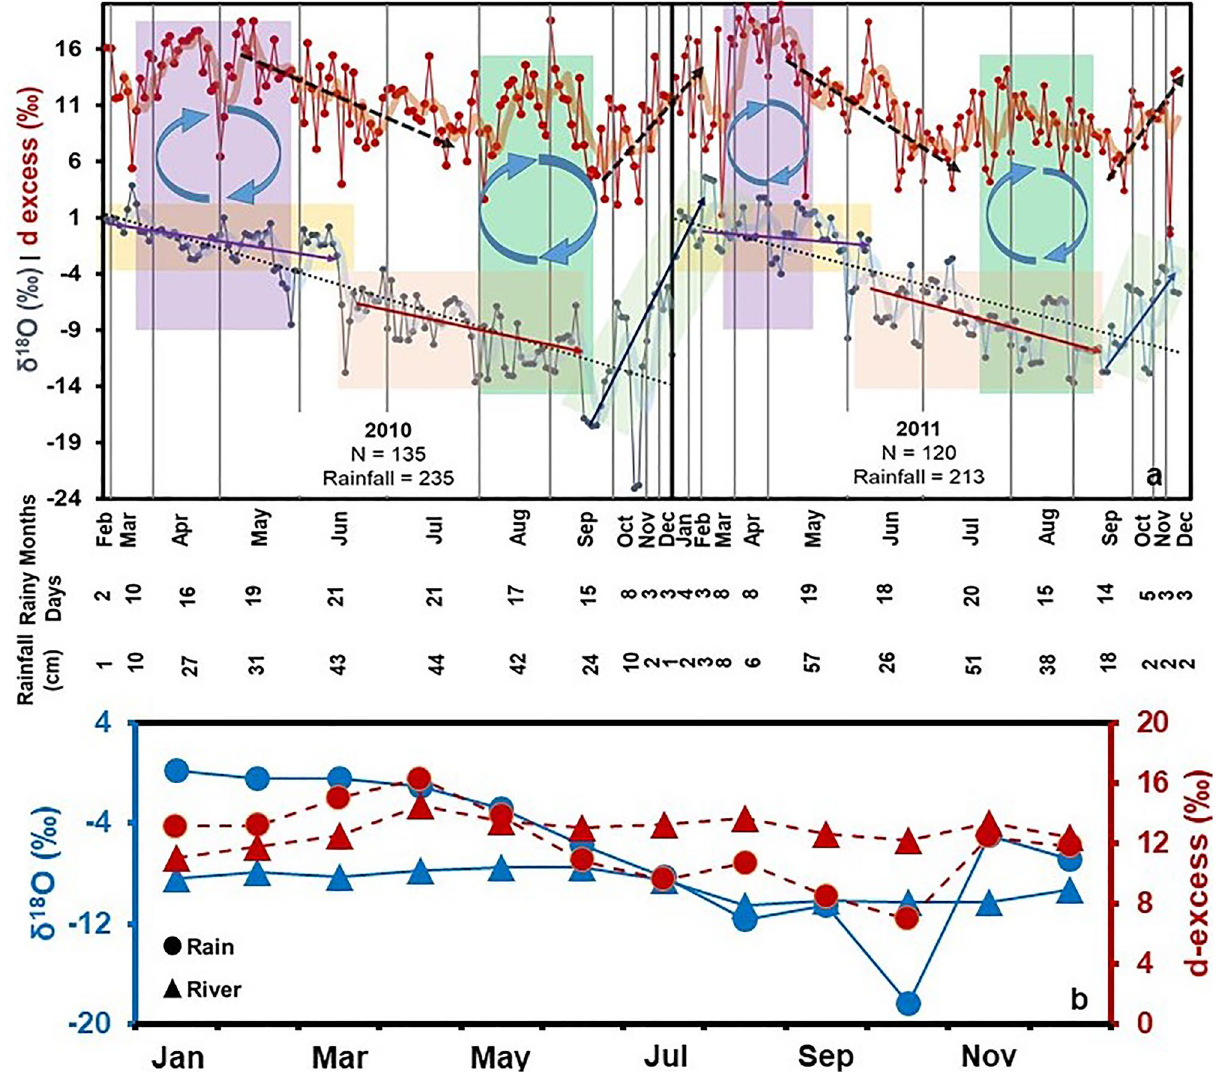
Figure 3. Isotopic trends in Precipitation and river water. ( a ) The daily isotope records of precipitation collected at Jorhat during 2010–2011. The enriched δ 18 O and high d-excess during Pre-monsoon (Mar–May) coupled with conspicuous slightly increasing trend of d-excess during latter half of the ISM (June–Sep) is indicative of hugely important role of locally recycled moisture contributing to precipitation. ( b ) The seasonal variation of δ 18 O and d-excess for precipitation (circle) and Brahmaputra (triangle) river water samples. Brahmaputra data shows overall high average d-excess and depleted δ 18